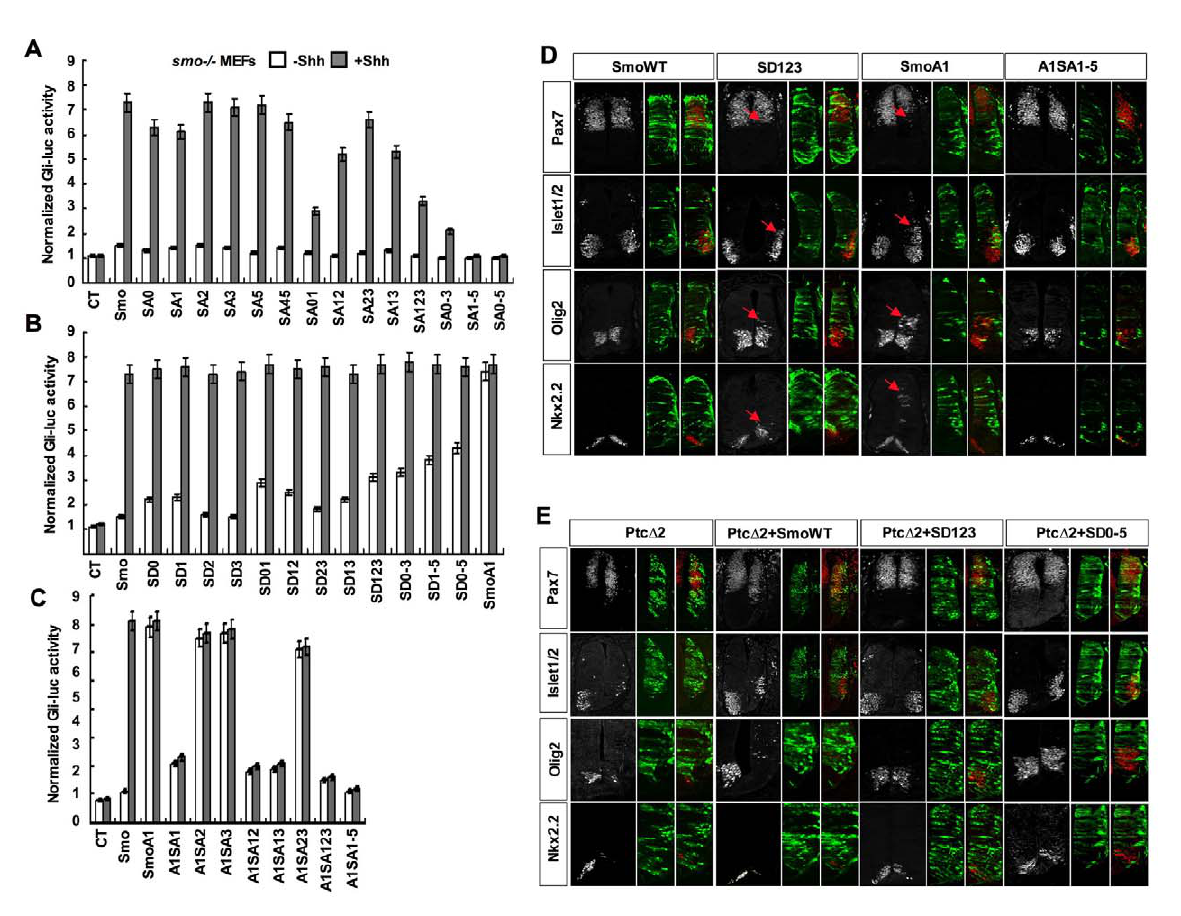
Figure 3. Phosphorylation at multiple CK1 and GRK sites regulates Smo activity both in vitro and in vivo. (A–C) Gli-luc activity assays for smo 2 / 2 MEFs transfected with the indicated Smo expressing constructs together with the 8XGliBS-luc reporter gene and a control pRL-TK . The cells were treated with or without Shh-conditioned medium 2 d after transfection. (D–E) HH st11–12 chick neural tubes were electroporated with the indicated expression constructs and assayed by immunohistochemistry 48 h after transfection. (D) The expression of Pax7, Islet1/2, Olig2, and Nkx2.2 in anterior thoracic regions of embryos transfected with wild-type Smo (SmoWT), SmoSD123, SmoA1, or SmoA1SA1–5. Cells expressing the constructs were identified by CFP (green). Arrows indicate the expanded expression of Islet1/2, Olig2, and Nkx2.2 and the reduction of Pax7 expression. SmoA1 exhibited potent constitutive activity, leading to the repression of Pax7 and induction of ectopic Islet1/2, Olig2, and Nkx2.2. Mutating multiple CK1/GRK sites in SmoA1 (A1SA1–5) diminished its constitutive activity. SmoSD123 also exhibited constitutive activity, resulting in a reduction of Pax7 expression and expansion of Islet1/2, Olig2, and Nkx2.2, albeit less dramatic than SmoA1. Note that there was also a subtle expansion of Olig2 in some embryos transfected with SmoWT. (E) Embryos co-transfected at a ratio of 2:1 with Ptc1 D loop2 (Ptc D 2) and either Smo-WT, SmoSD0–5, or SmoA1 and assayed for Pax7, Islet1/2, Olig2, and Nkx2.2 expression. Ptc1 D loop2 inhibits Shh signaling resulting in the repression of Islet1/2, Olig2, and Nkx2.2, and a ventral expansion of Pax7. SmoSD123 and SmoSD0–5 but not SmoWT overcame the dominant inhibitory effect of Ptc1 D loop2